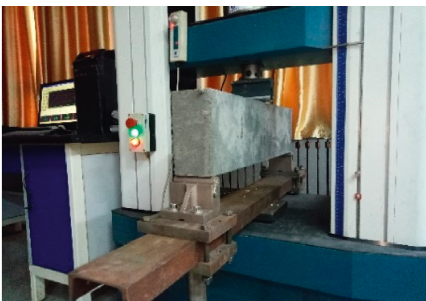
Figure 2: Test equipment with a concrete beam in the test